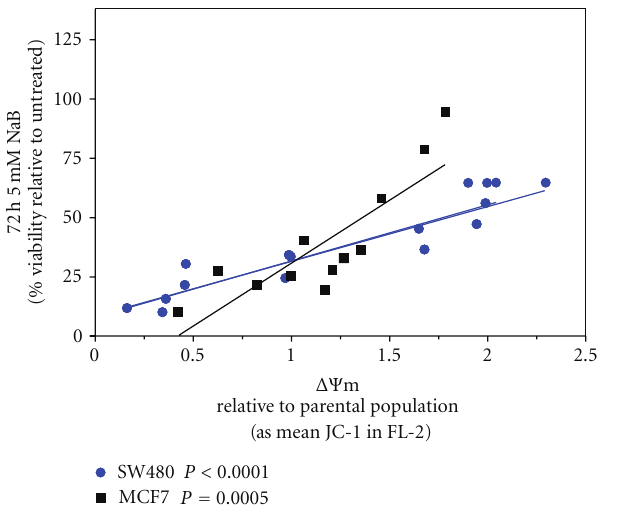
Figure 4: Di ff erences in the intrinsic ΔΨ m of subcloned cell lines derived from primary colonic and mammary tumors are linked to phenotypes associated with solid tumor expansion. VEGF was quantified by ELISA in condition medium harvest from SW480 and MCF7 cell lines, and subclones derived from each of the cell lines, and normalized for cells/well by the MTT assay. VEGF secretion levels are plotted as a function of relative ΔΨ